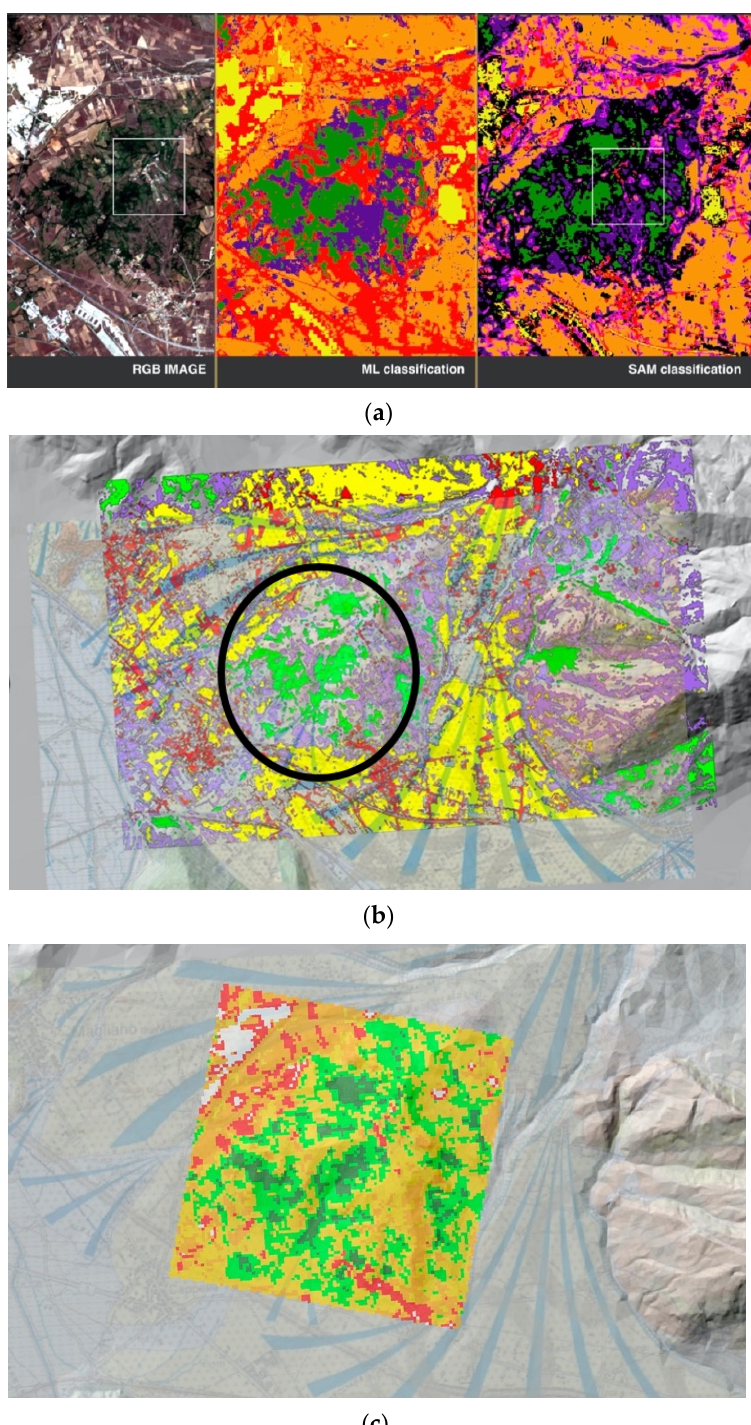
Figure 17. Sentinel-2 maximum likelihood (ML) and spectral angle mapper (SAM) classification in the Alba Fucens’ AOI: ( a ) the SAM classification distinguished the archaeological area and two soil types in more detail: around the site (purple class) and in the surrounding (orange class); ( b ) relationships classification/geology—light soils, dark soils (Red: antropic features, Yellow: light soils, Purple: dark soils, Green: vegetation); and ( c ) PRISMA SAM classification and geology relationships (Red: antropic features, Orange: dark soils, Light Orange: light soils, Light green: low vegetation, Dark Green: high vegetation; geology map: concession and use by ISPRA—Department for the Geological Survey of Italy).